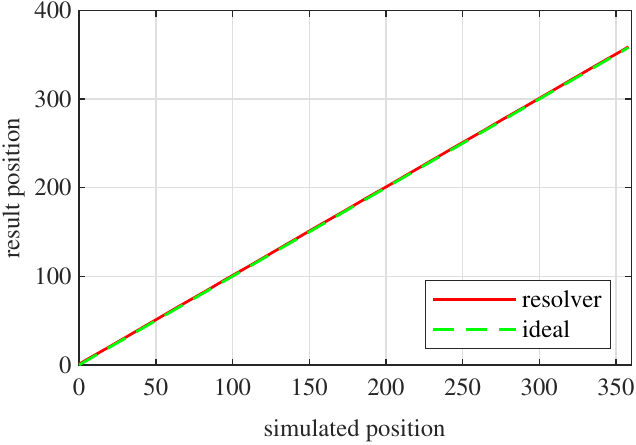
Figure 32. Toroidal slotless skewed resolver position vs. the ideal position.